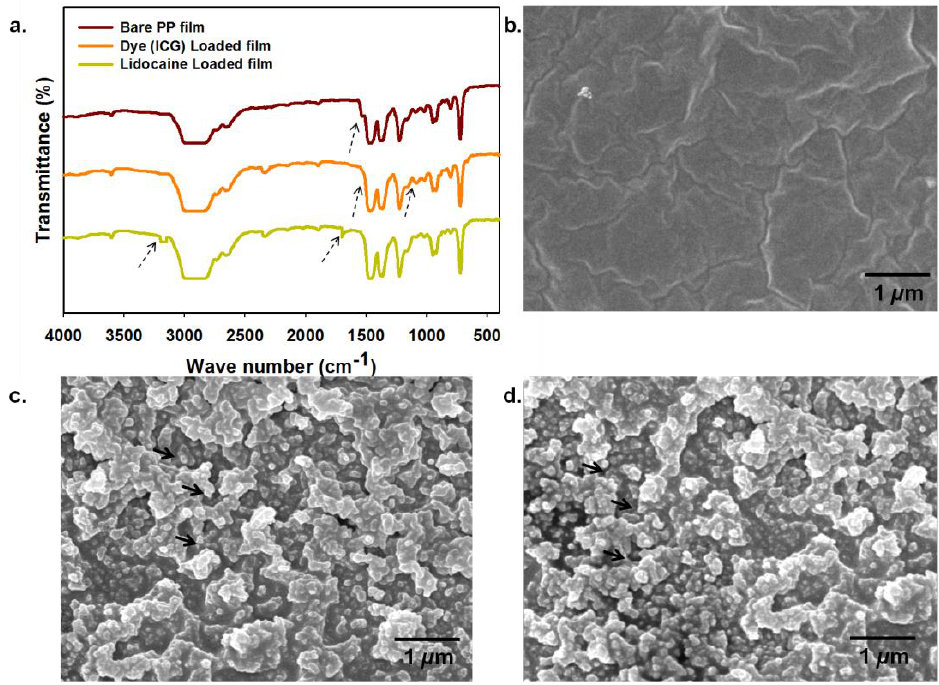
Figure 1. ( a ) The FT-IR transmission peaks of bare PP film, dye (ICG)-loaded PP film, and lidocaine-loaded PP film. The scanning electron microscopic (SEM) images (scale bar 1 µm) of ( b ) bare PP film, ( c ) dye (ICG)-loaded PP film, and ( d ) lidocaine-loaded PP film, where the arrow shows the site of loading in the PP